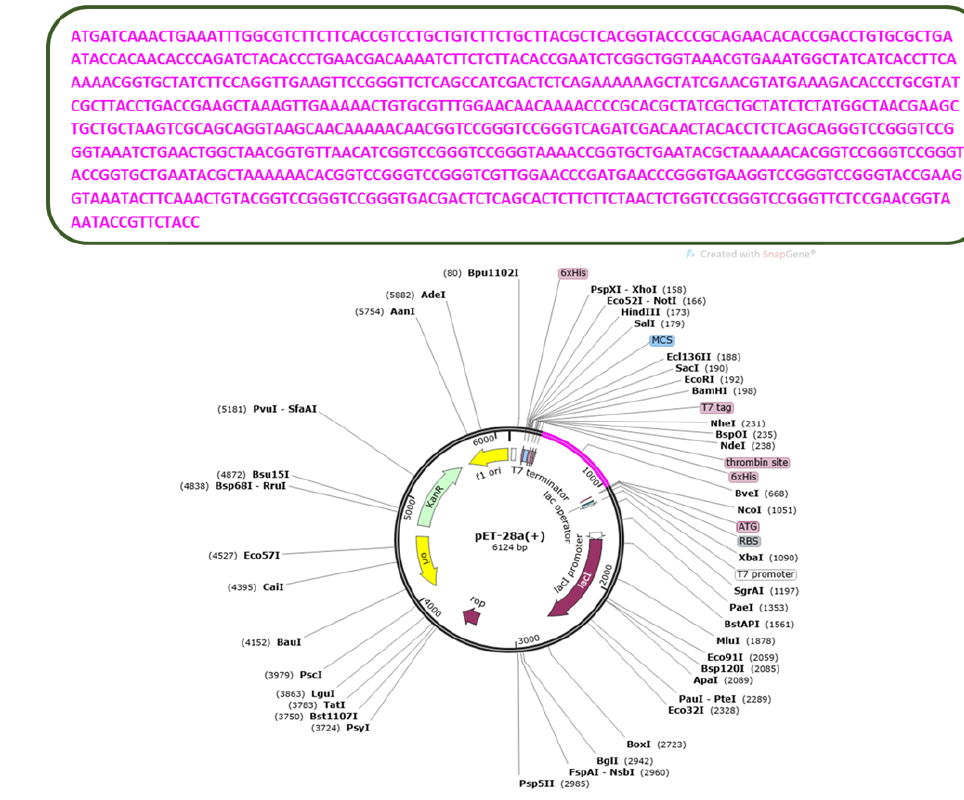
Figure 6. The cloned pET 28a (+) Vector.